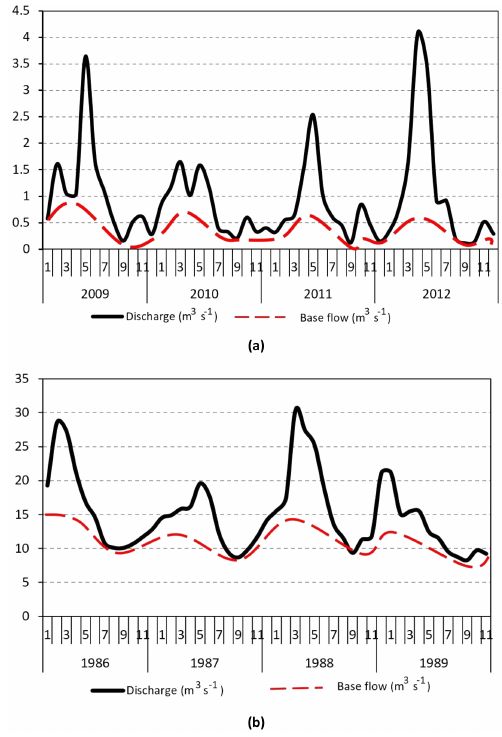
Figure 7. Hydrograph for fast flow springs: (a) Pınargözü spring (conduit-dominated poor base flow), (b) Kirkgozler spring (conduit-dominated large base